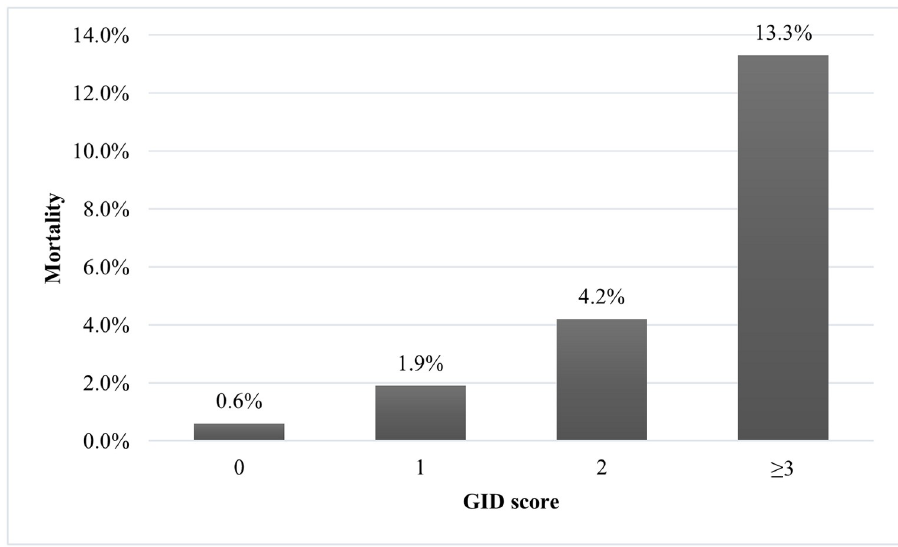
Fig 1. Mortality rates in three groups of GID score (0 vs. 1 vs. 2 vs. � 3). GID, geriatric influenza death.